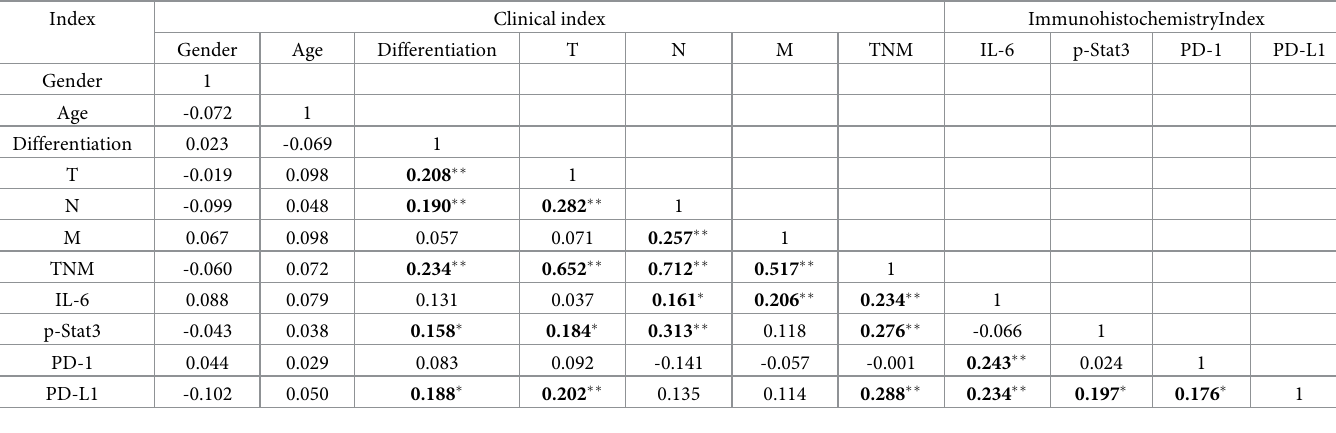
Table 1. Cross correlation analyses of various indices in gastric cancer